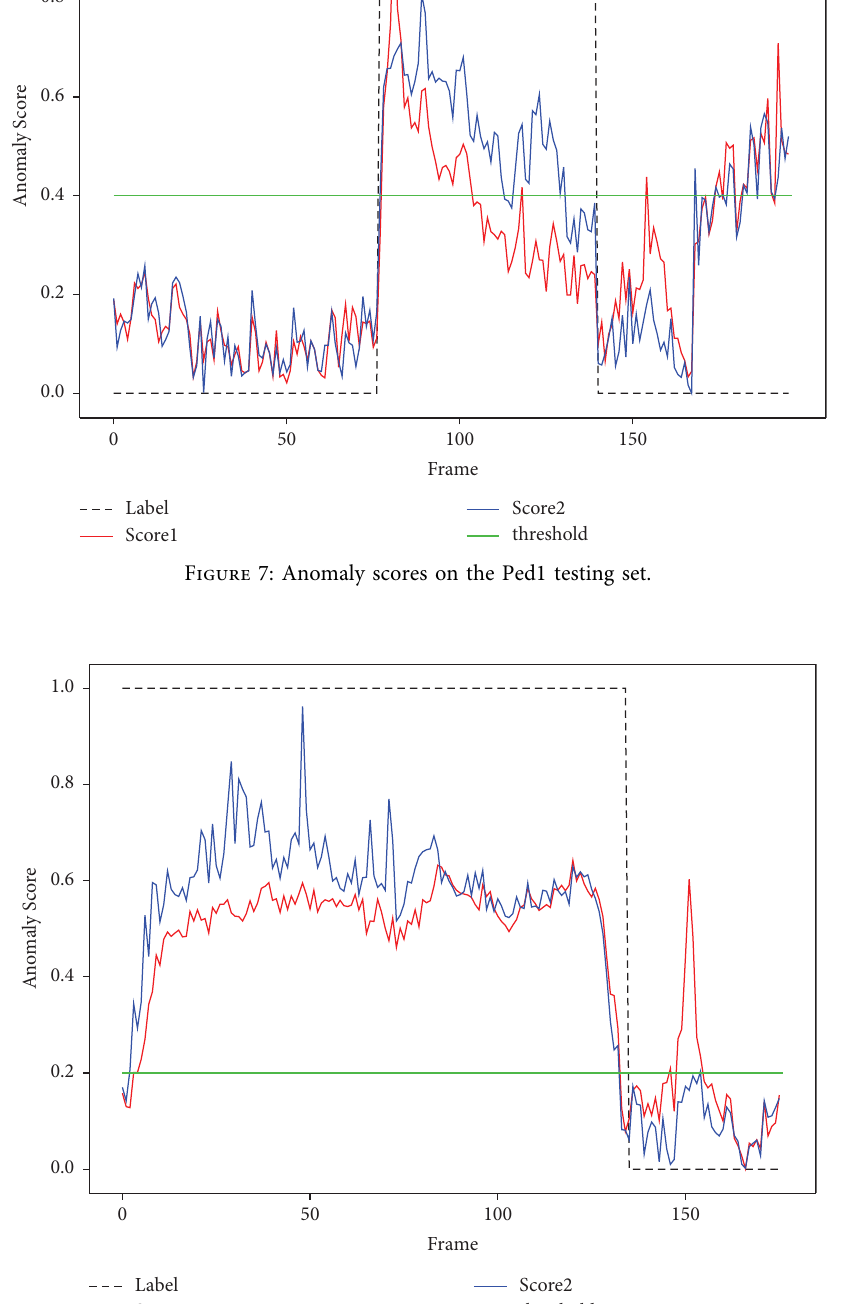
Figure 8: Anomaly scores on the Ped2 testing